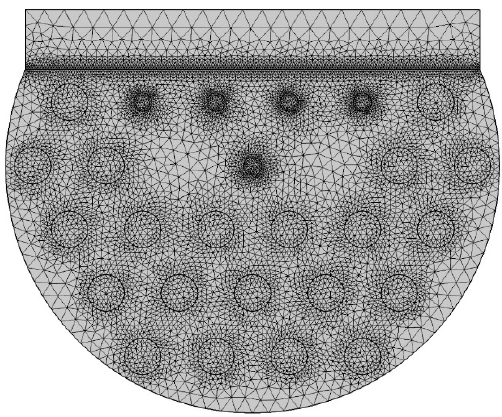
Figure 2. The mesh division of the proposed D-shaped PCF.